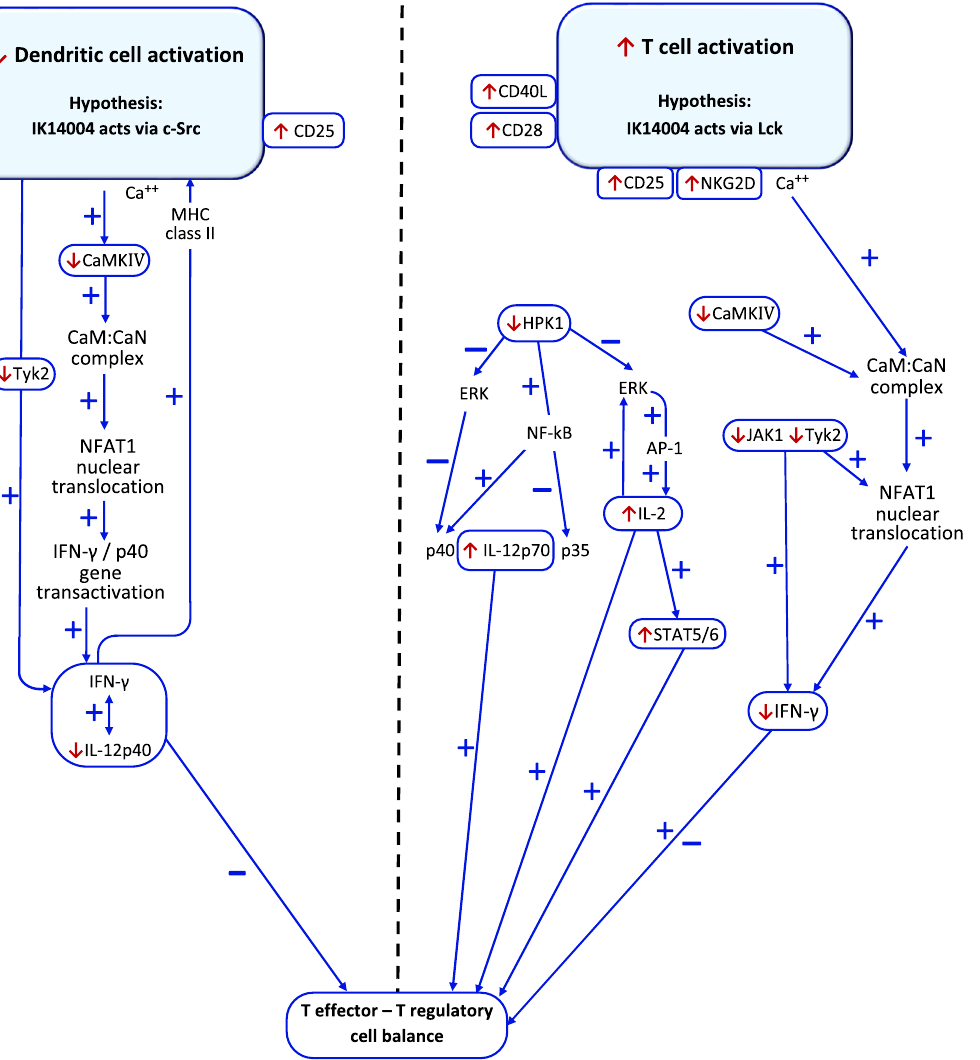
Figure 7. Schematic illustrating immunomodulatory effect of IK14004 and putative effects on kinase activities relevant to maintaining a balanced immune response. Known regulatory pathways are shown in blue arrows with blue ± symbols representing stimulatory/inhibitory effects, respectively. IK14004 effects are shown as upward or downward red arrows representing stimulatory/inhibitory effects, respectively. Whether the contrasting effects of IK14004 on activity of Lck and c-Src in non-cell-based assays are physiologically relevant remains to be established in cell-based systems. IK14004 suppresses DC activation and production of IL-12p40 which regulates IFN-γ expression in a positive feedback loop. T cell production of IL-2 and IFN-γ is uncoupled and IK14004 alters the IL-12p70 : IL-12p40 ratio which has implications for maintenance of functional CD4+ Treg cell populations. IK14004 increases the proportion of Treg cells and induces expression of activating co-receptors in CD8+ T cells coupled with enhanced granzyme B expression. Taken together with STAT5 activation in CD8+ but not CD4+ T cells and changes in cytokine expression, these divergent effects suggest a role for IK14004 in maintenance of balanced immune responses involving T cell-DC